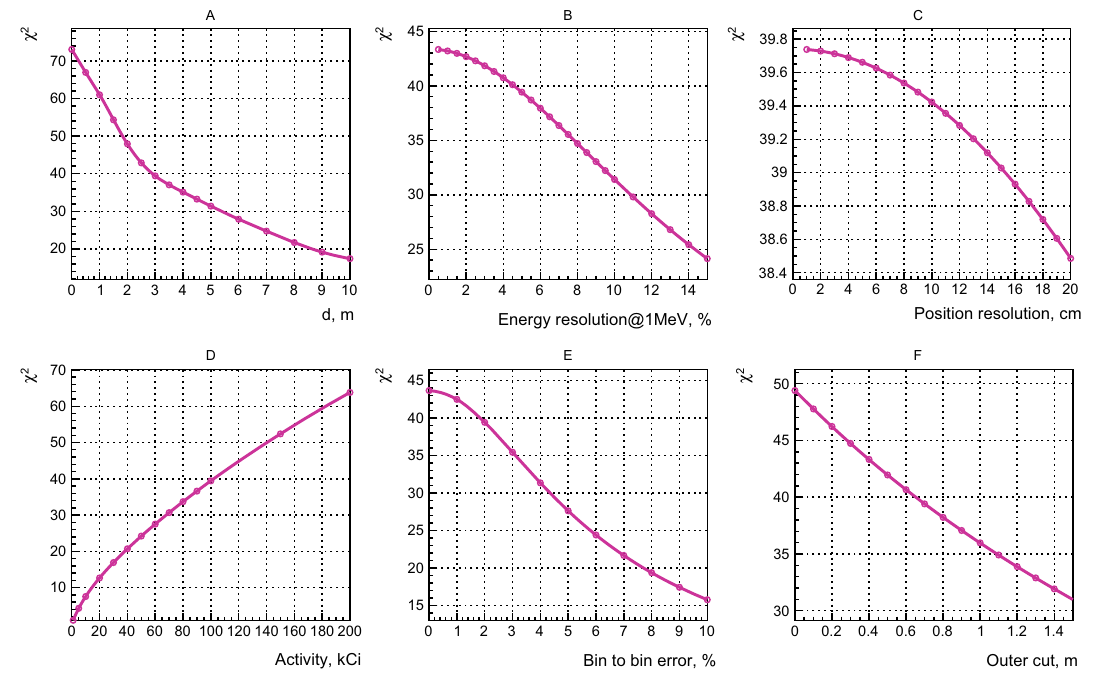
Fig. 5 The sensitivity of the experiment as a function of different parameters. Panel A corresponds to the distance between the source and the detector edge. Panel B corresponds to the energy resolution of Jinping. PanelCcorresponds tothepositionresolutionofJinping.Panel